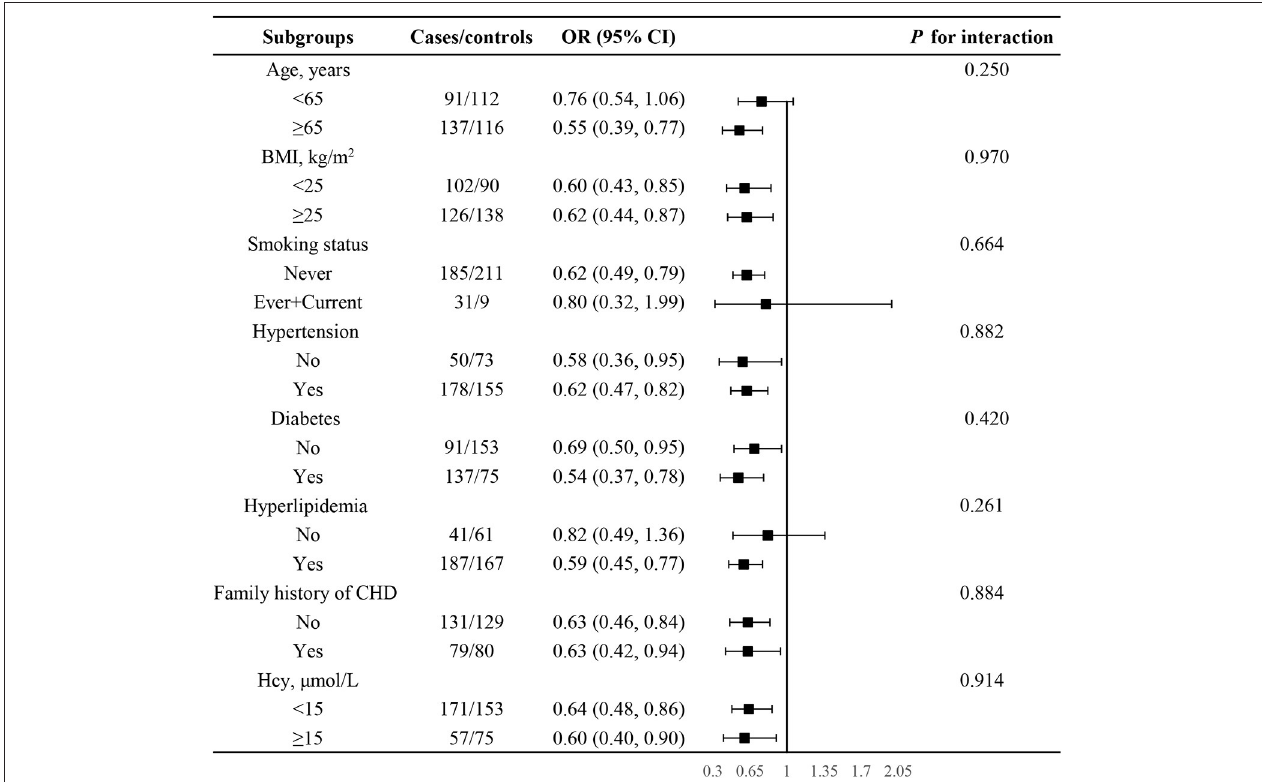
FIGURE 4 | Subgroup analyses to detect effect modification on the association between plasma log 2 PLP and CHD in women. Each subgroup analysis adjusted, if not stratified, adjusted for age, BMI, smoking status, drinking status, hypertension, diabetes, hyperlipidemia, family history of CHD and